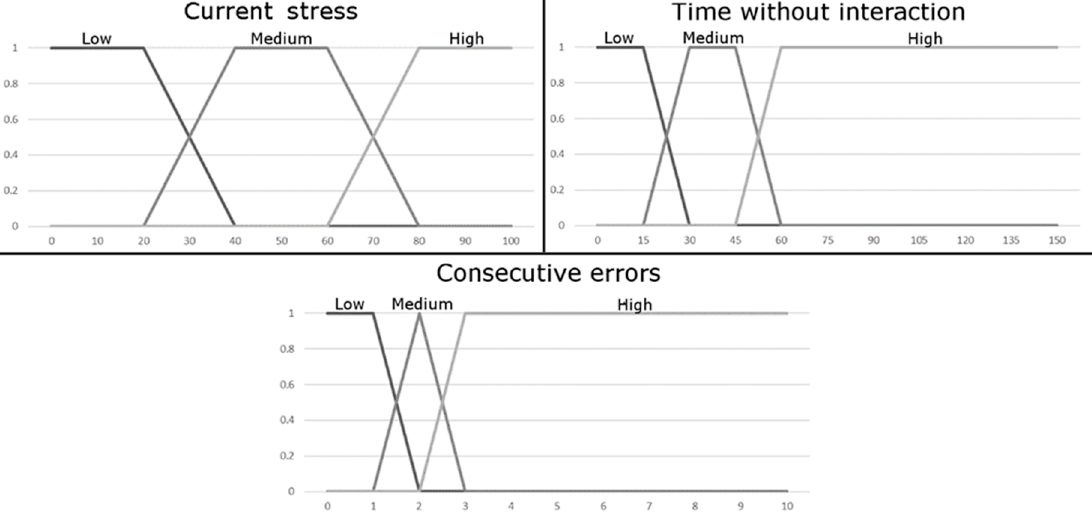
Figure 11. Input values of the FIS4H.